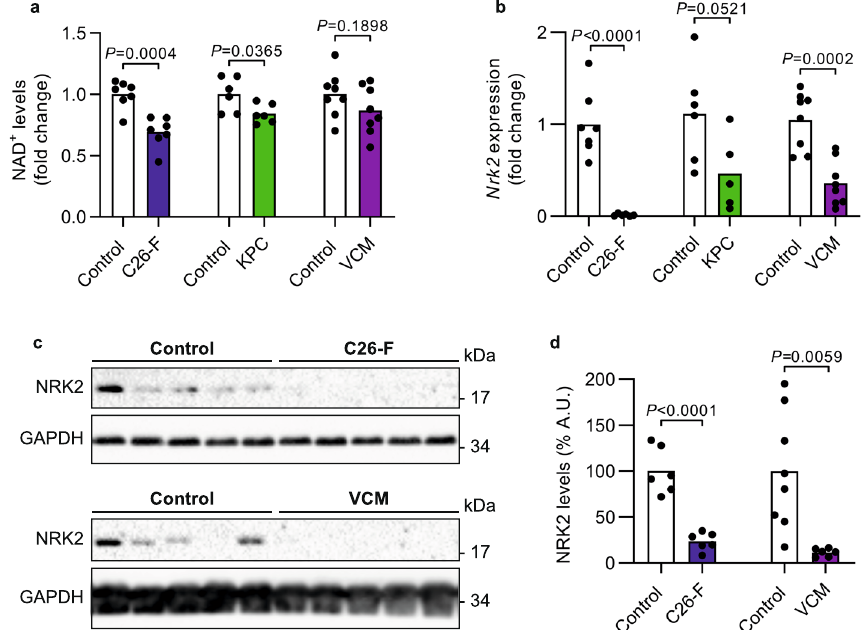
c , d Representative western blotting bands and densitometry analysis of NRK2 proteinlevelsonC26-F( n =6pergroup)andVCM(controls n =8,VCM n =6)mice. GAPDH was used as loading control. Mice age: C26-F 7-month-old, KPC 3-month- old, VCM 13-month-old. All controls are age-matched. Data are shown as means withindividualvalues.Statisticalanalysiswasperformedusingtwo-tailedStudent ’ s t test. Original raw data are provided as a Source Data fi le. A.U. arbitrary